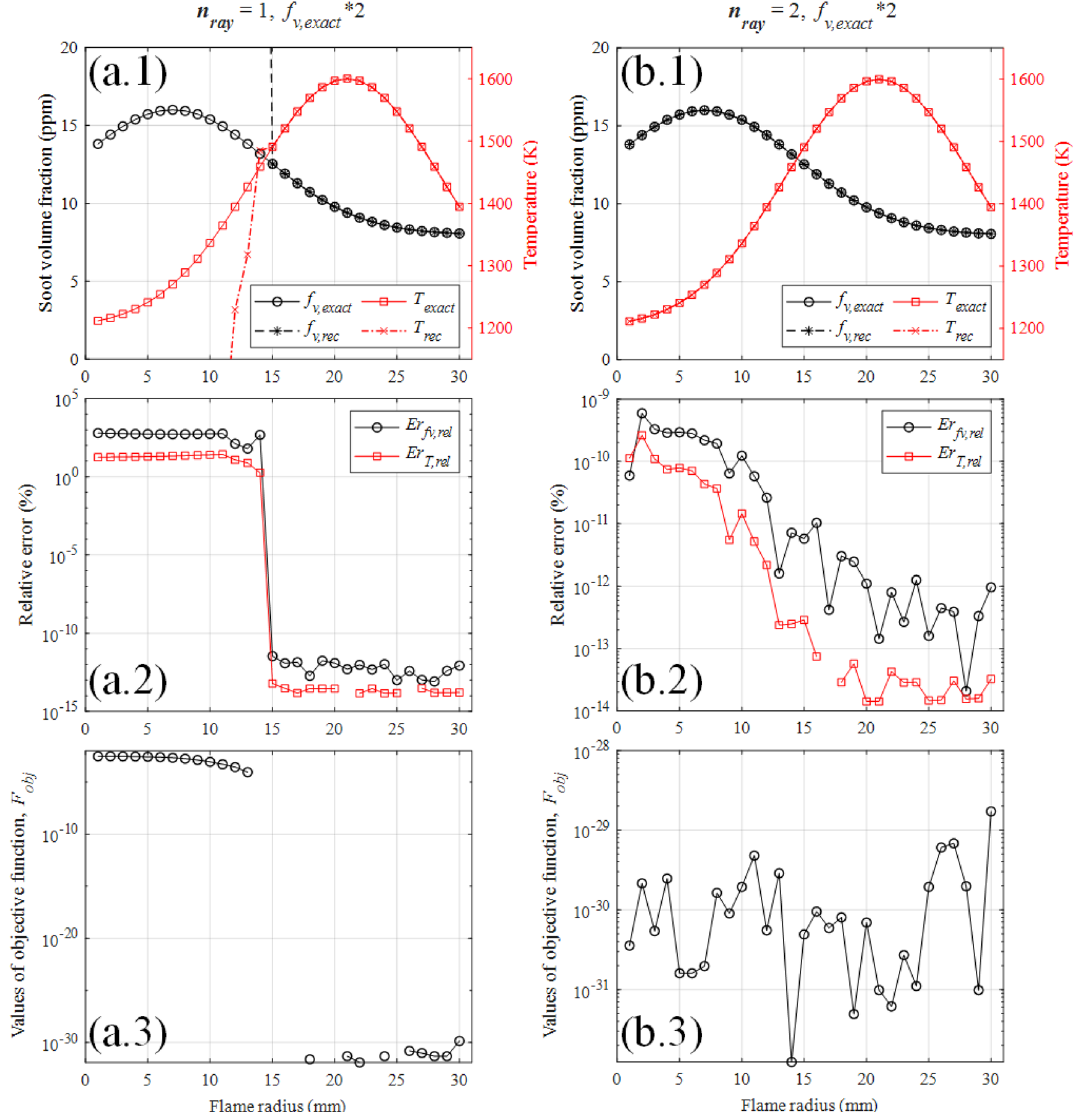
Figure 5. The reconstructed results (log scale values of zero are not displayed) with different n ray , while soot concentration filed was increased to 2 times of the original. ( a ) n ray = 1. ( b ) n ray =